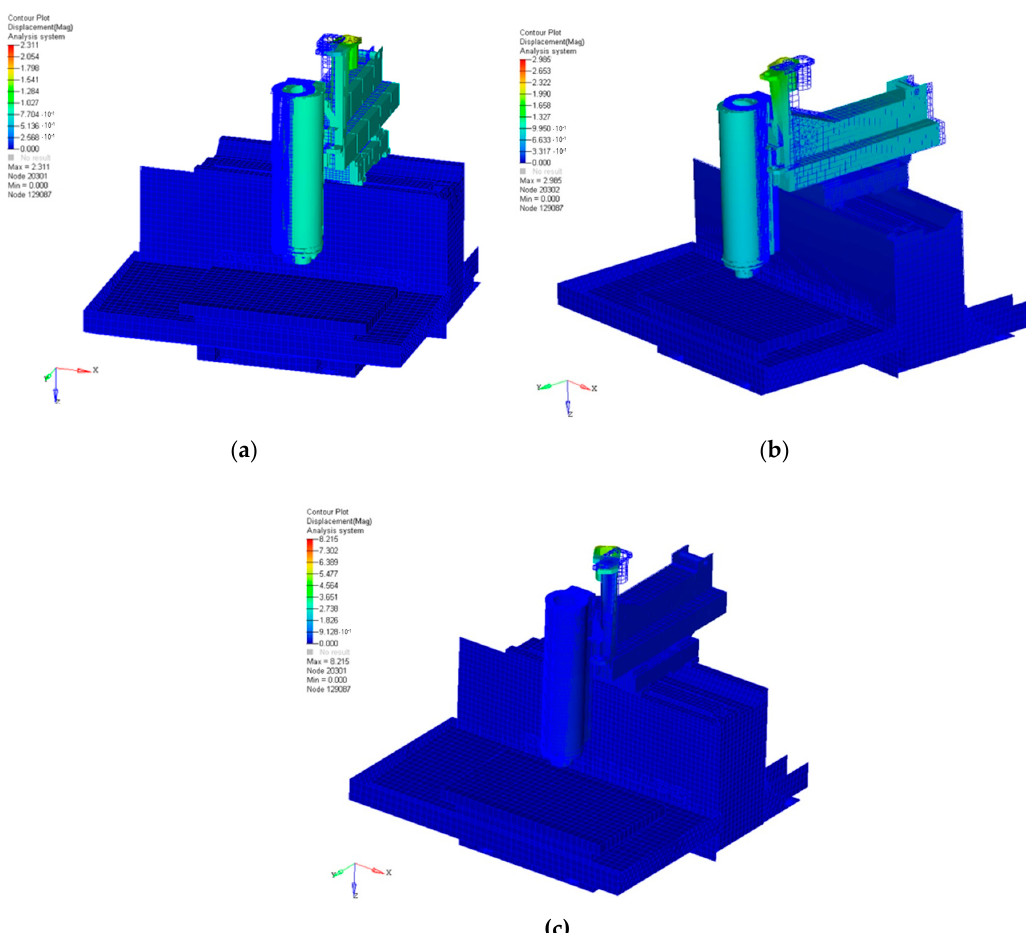
Figure 5. The FE modes 1–3 at 19 Hz ( a ), 24 Hz ( b ), and 30 Hz ( c ), respectively.